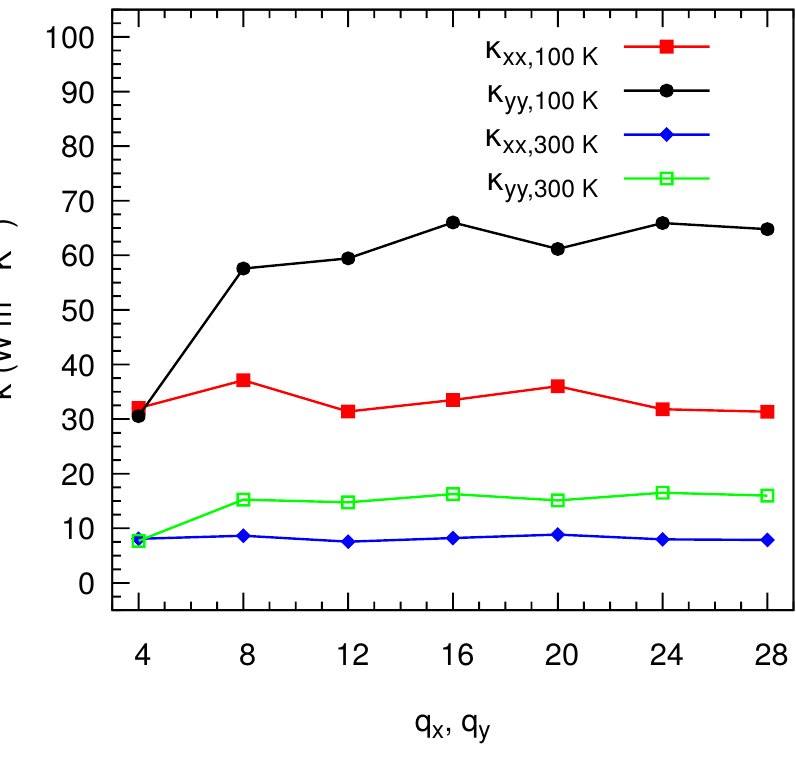
Figure 2. Thermal conductivity as a function of the number of q -points in the x (q x ) and y (q y ) directions at 100 K and 300